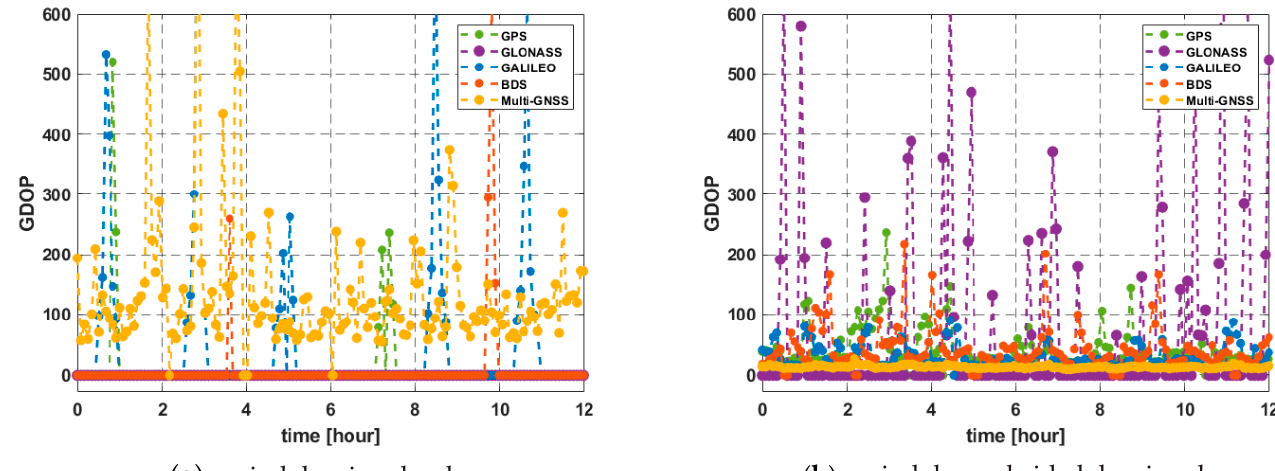
Figure 9. GDOP for 24 h in geostationary orbit above Korea (128° E ). However, the GDOP can be relatively lower at the opposite side due to BDS satellites observed additionally, i.e., GDOP benefits greatly from non-MEO BDS satellites in this case. In particular, the GDOP of BDS has a value that is fairly small enough to approach multi-GNSSs when using the side-lobe signal together. The mean of the GDOP using the side lobe signal together was 8.27. These are summarized in Table 3.